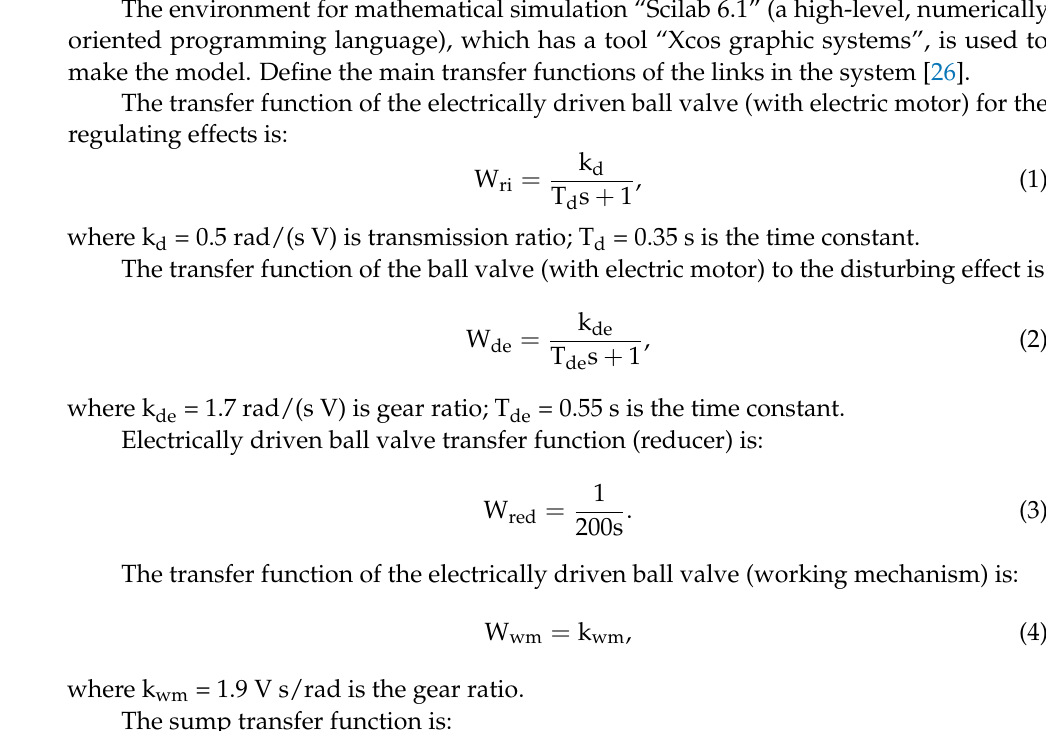
Figure 4. Functional diagram of the primary circuit of the heat exchanger of a heat supply system, including acoustic– magnetic devices.